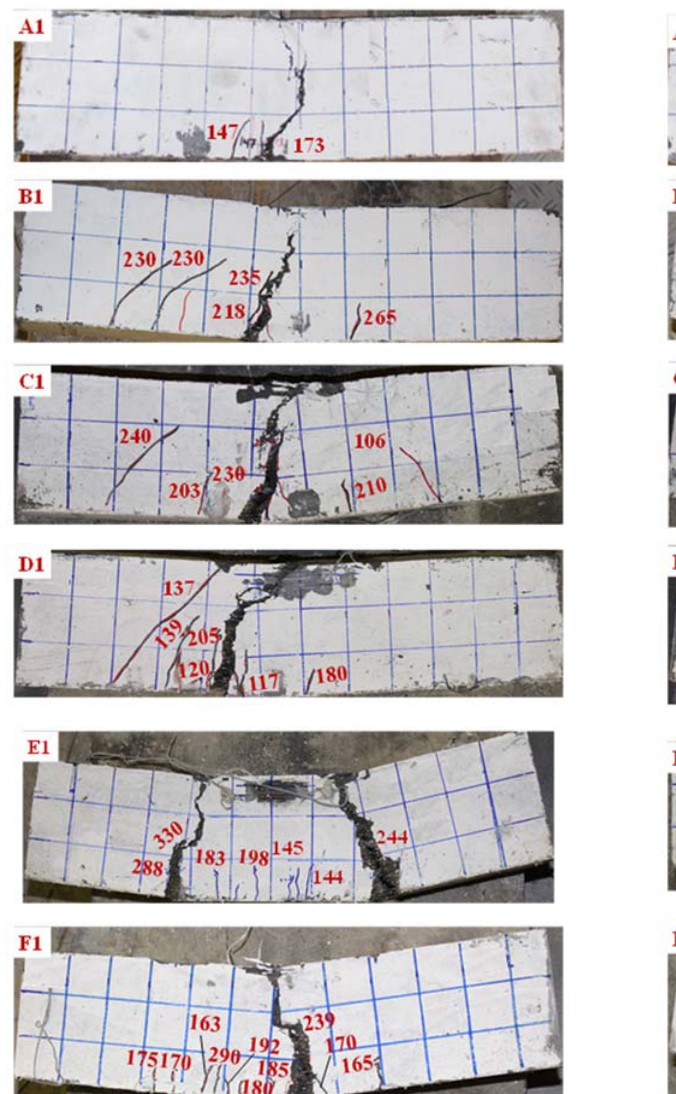
Figure 8. Definition of elastic, yield, and ultimate phases.